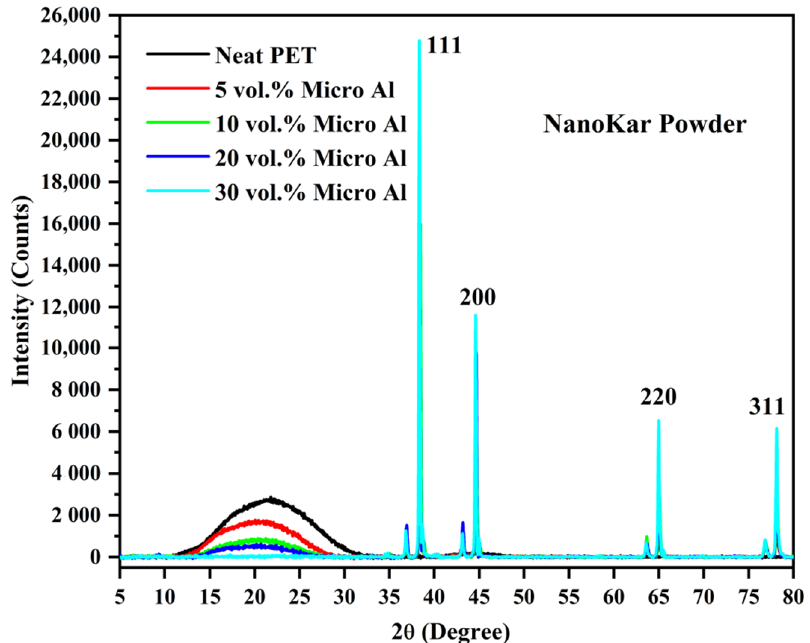
Figure 4. X-ray Di ff ractograms of the micro-Al 1 / amorphous PET composites. The broad peak at 2 θ Figure 4. X-ray Diffractograms of the micro-Al 1/amorphous PET composites. The broad peak at 2θ values between 11 ◦ and 33 ◦ confims the PET is in an amorphous values between 11 and 33° confims the PET is in an amorphous state.